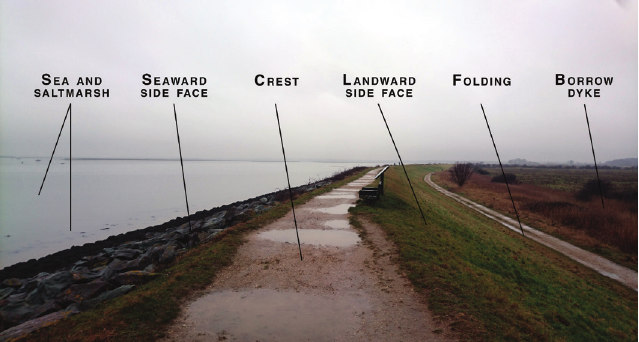
Fig. 1. The typical composition of a sea wall (Brightlingsea, Essex); credit K. Fargeaud.